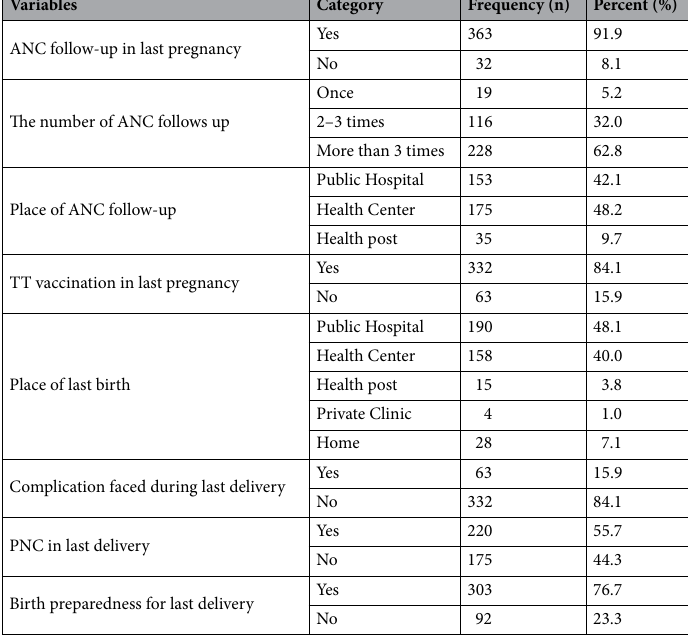
Table 2. Utilization of maternal and newborn health services of respondents in North Shewa zone, Oromia Region, Ethiopia (N = 395). ANC antenatal care, PNC post-natal care, TT tetanus toxoid.